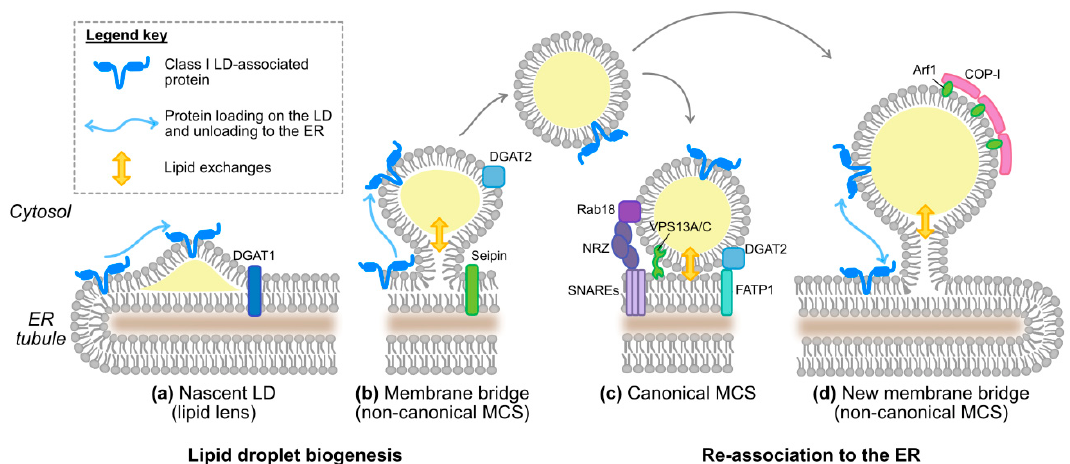
Figure 3. Contacts and exchanges between lipid droplets and the endoplasmic reticulum (ER). ( a ) Lipid droplets form by acyl-CoA:diacylglycerol O-acyltransferase 1 (DGAT1)-mediated triglyceride accumulation between the two ER leaflets. Some ER-associated proteins, such as ASCL3, a class I LD-associated protein, traffic to LDs during this early stage of LD production [59]. ( b ) Upon LD expansion catalyzed by DGAT2, some LDs maintain membrane bridges with the ER, in a process regulated by seipin [60]. ( c ) Detached lipid droplets might reconnect with the ER via conventional MCSs tethered by protein complexes (e.g., DGAT2-FATP1 [61], SNAREs-NRZ-Rab18 [62,63]) and/or by lipid transporters docked both on the ER and the LD surface (e.g., VPS13A/C) [64] (see main text). ( d ) Alternatively, new membrane bridges can reversibly reconnect LDs and ER and permit the regulated loading of the lipogenic protein GPAT4 [39] and the lipolytic protein ATGL [65,66] (not shown in the figure) from the ER. Membrane bridge formation involves the COP-I/Arf1 machinery. COP-I/Arf1 proteins are believed to extract phospholipids from the lipid droplet surface by triggering the budding of nano-lipid droplets, which have a very high surface to volume ratio. The phospholipid depletion results in an increased surface tension and lipid droplet instability, which promotes the establishment of membrane bridges with the ER [67]. Of note, the connections between LDs and ER have been investigated in various experimental systems (e.g., Drosophila S2 cells, human adipocyte cell lines, etc.) but their relevance in human hepatocytes or hepatoma cell lines often requires confirmation.